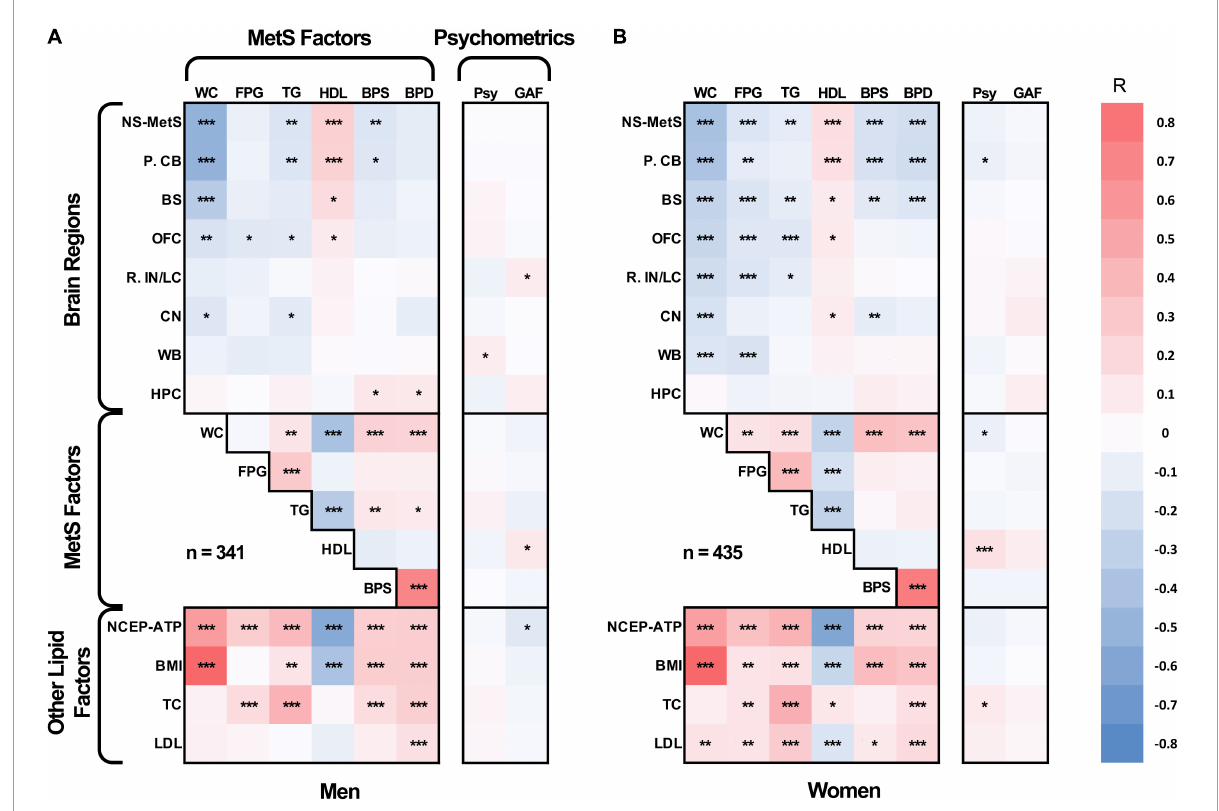
FIGURE2 Age-adjusted partial Pearson’s correlation tables in men (A) and women (B) for gray matter densities of the neural signature of metabolic syndrome (NS-MetS); its substructures: posterior cerebellum (P. CB), brainstem (BS), orbitofrontal cortex (OFC), right insular/limbic cluster (R. IN/LC), caudate nuclei (CN); control brain regions: whole brain (WB) and hippocampus (HPC); components of metabolic syndrome: waist circumference (WC), log-transformed fasting plasma glucose (FPG), log-transformed triglycerides (TG), high-density lipoprotein cholesterol (HDL), systolic blood pressure (BPS), and diastolic blood pressure (BPD); other biometric values: national cholesterol education program adult treatment plan III metabolic syndrome index score (NCEP-ATP), body mass index (BMI), total cholesterol (TC), and low density lipoprotein cholesterol (LPL); and cognitive/psychometric function scores: global assessment of functioning scale (GAF), and latent variable of GOBS psychometric tests composite (Psy). ***Significant at p ≤ 0.001, **significant at p ≤ 0.01, *significant at p <